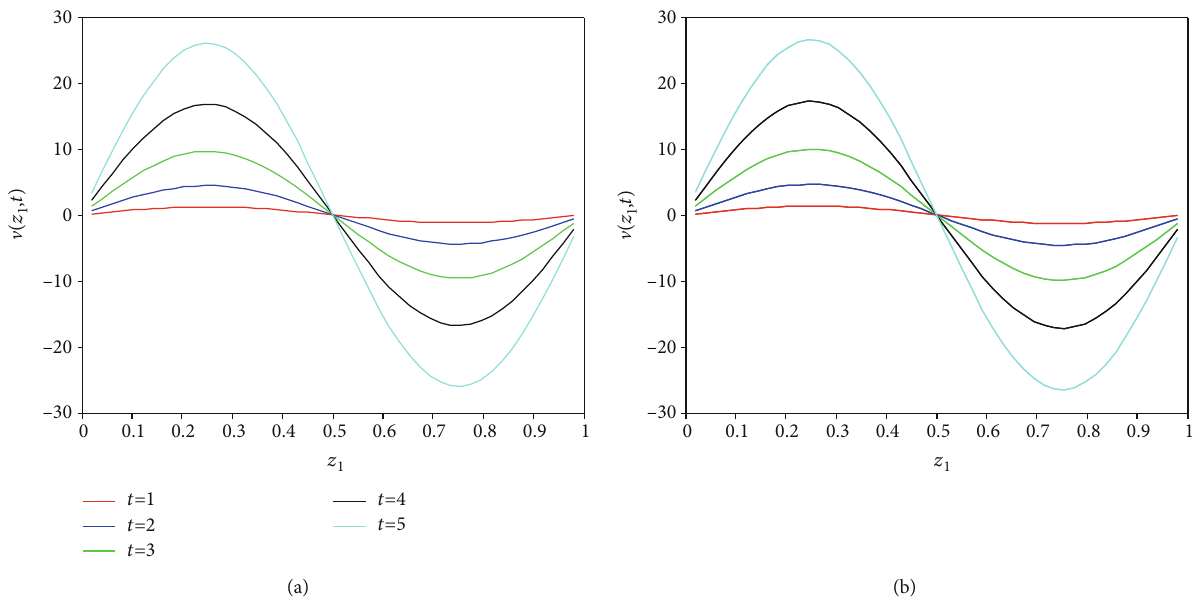
Figure 3: Approximate solution at di ff erent time levels by using (a) IS and (b) CNS for the Problem